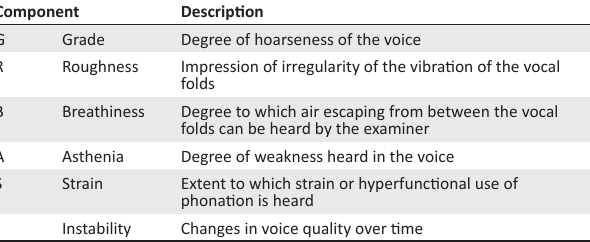
TABLE 2: GRBASI 4-point rating scale.